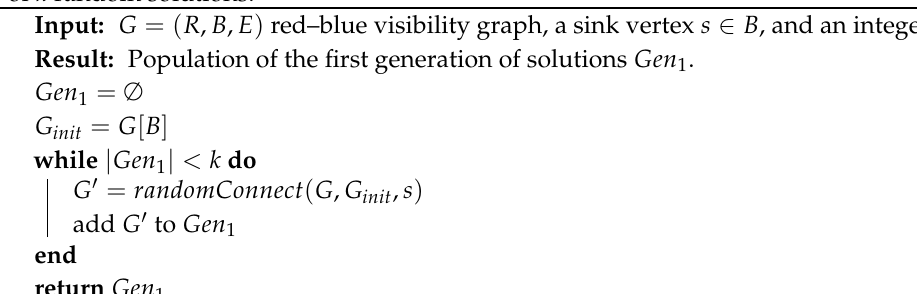
Algorithm 1: Pseudocode of f irstGeneration , which creates the initial population that consists of k random solutions.